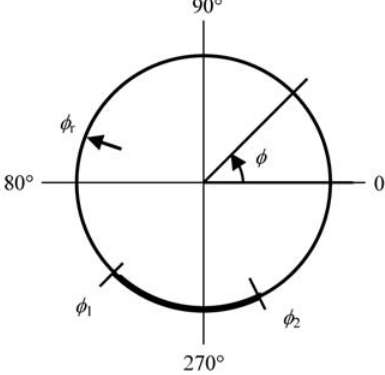
Figure 1. Schematic of the mathematical model. The circumference represents the surface of the TC, on which TCR is distributed by lateral diffusion. Position on the surface is specified by the angular coordinate w as shown. w 1 and w 2 denote the instantaneous positions of the two moving boundaries of the TC-APC contact area shown as the heavy arc. TCR is internalized from the contact area with the high ligand-induced rate constant k i , and from the rest of the surface, with the lower constitutive rate contact k c . Polarized recycling of the internalized receptors is directed to the position denoted w r , which is adjacent to the eccentric intracellular RC not shown in the diagram. The recycling position and the positions of the boundaries as shown are arbitrary. In the model, the recycling position w r is fixed and the boundaries w 1 and w 2 can move along the surface, expanding or contracting the contact area according to whether the local receptor density P ( w , t ) at the boundaries is above or below the critical density p crit for attachment to the